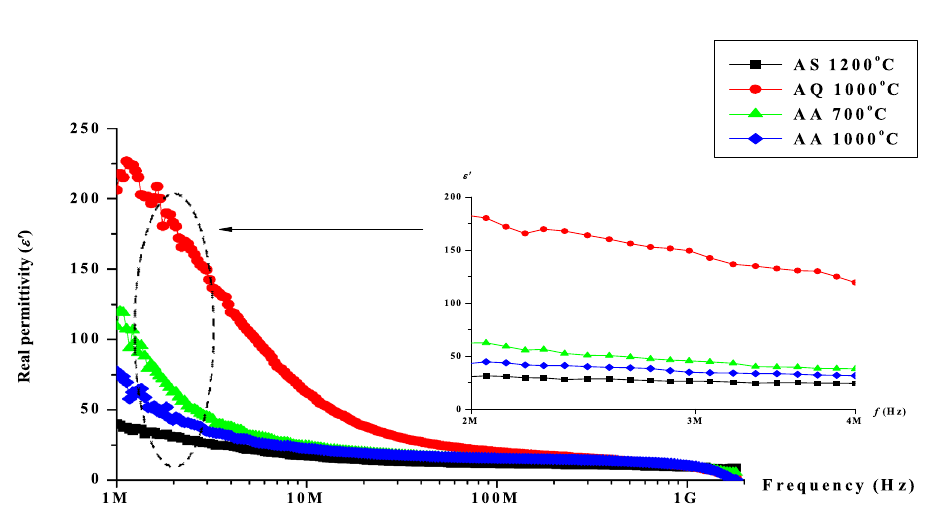
Figure 10. Graph of real permittivity, ε ′ as a function of frequency after sintering at 1200 °C, after quenching at 1000 °C, after annealing at 700 and 1000